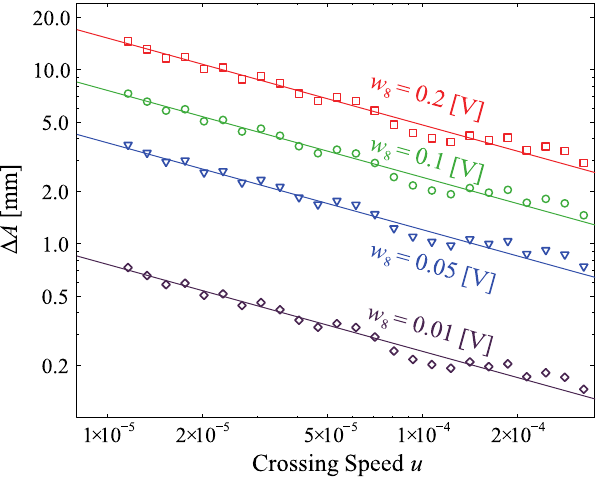
FIG. 15. Numerical results obtained from 2D W ARP simulations without space-charge interactions and external nonlinear fields. The maximum transverse amplitude of an ion plasma after crossing the integer resonance stop band at n ¼ 8 is plotted as a function of crossing speed u . The tune-variation range is chosen the same as in Fig. 8. The solid lines are given by the scaling law ffiffiffi p Δ A ¼ g u with g 8 ¼ 0 . 30 . 8 w 8 =